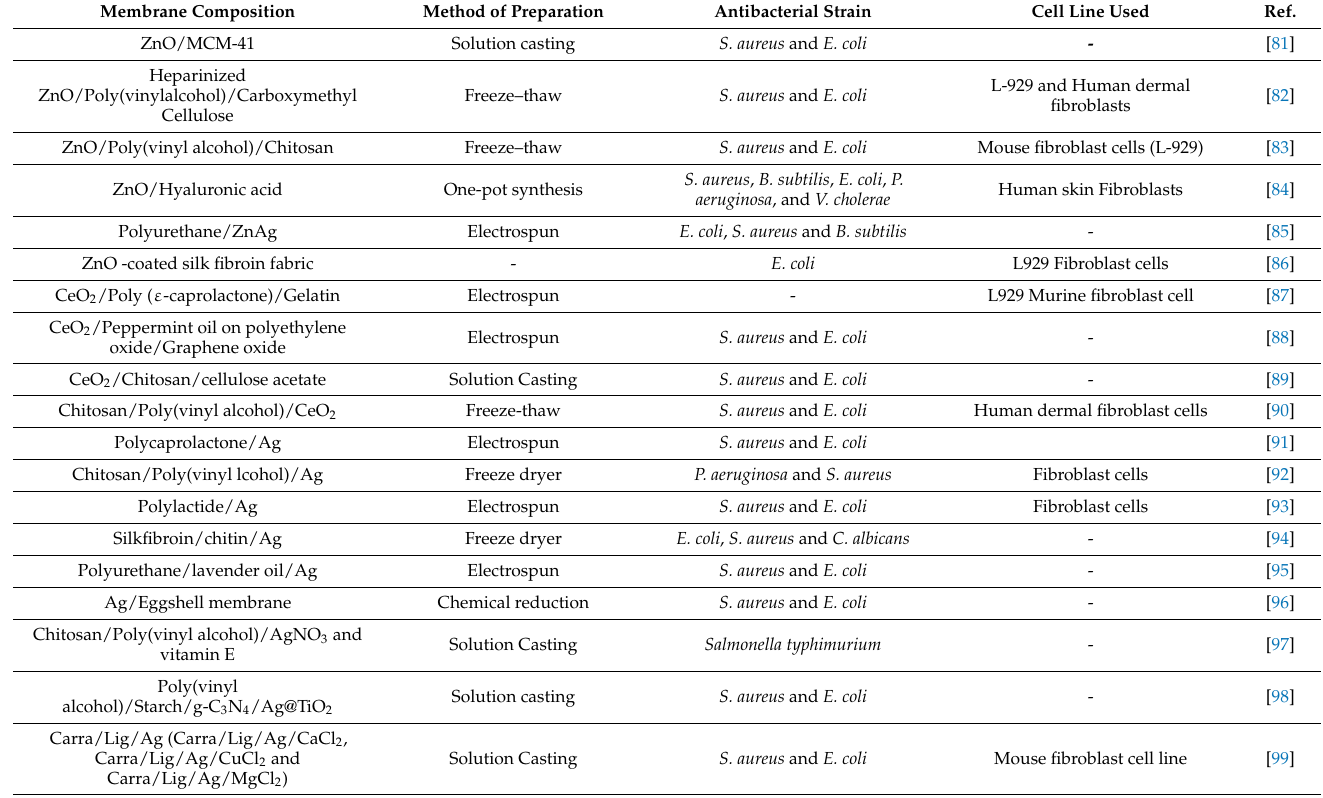
Table 2. Summary of recently used biopolymers, synthetic polymers and nanoparticles in wound dressing. Membrane Composition Method of Preparation Antibacterial Strain Cell Line Used Solution